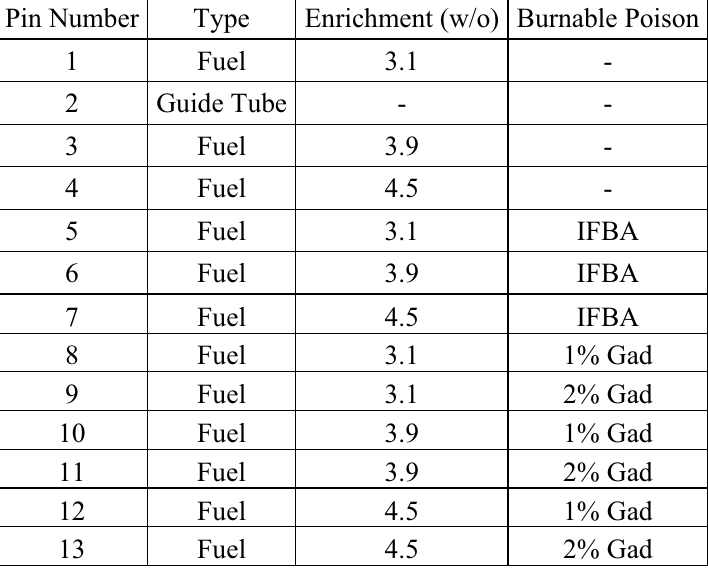
Table III. Encoding: The one-hot encoding used to represent each of the pin types used in the